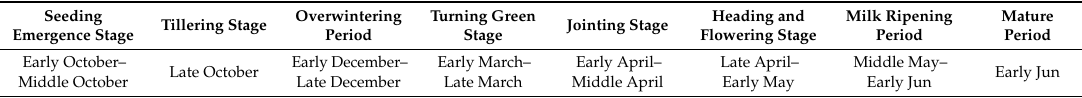
Table 1. The specific phenological periods of winter wheat in